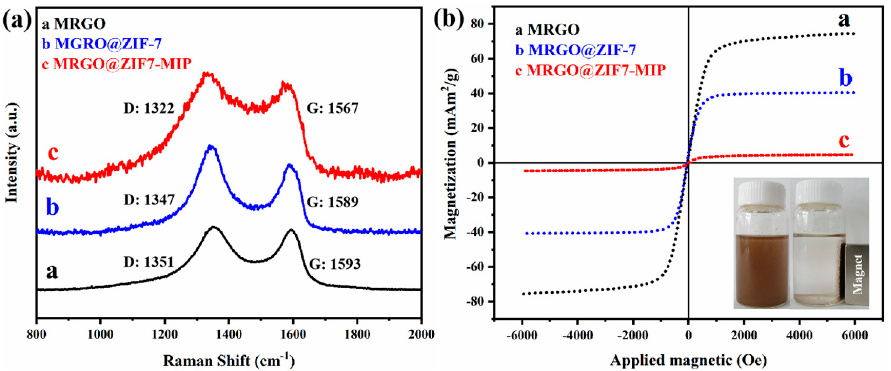
Figure 4. ( a ) Raman spectra and ( b ) magnetic hysteresis loop of the MRGO, MRGO@ZIF-7, and RGO@ZIF7-MIP. The inset shows the separation process of the RGO@ZIF7-MIP solution under